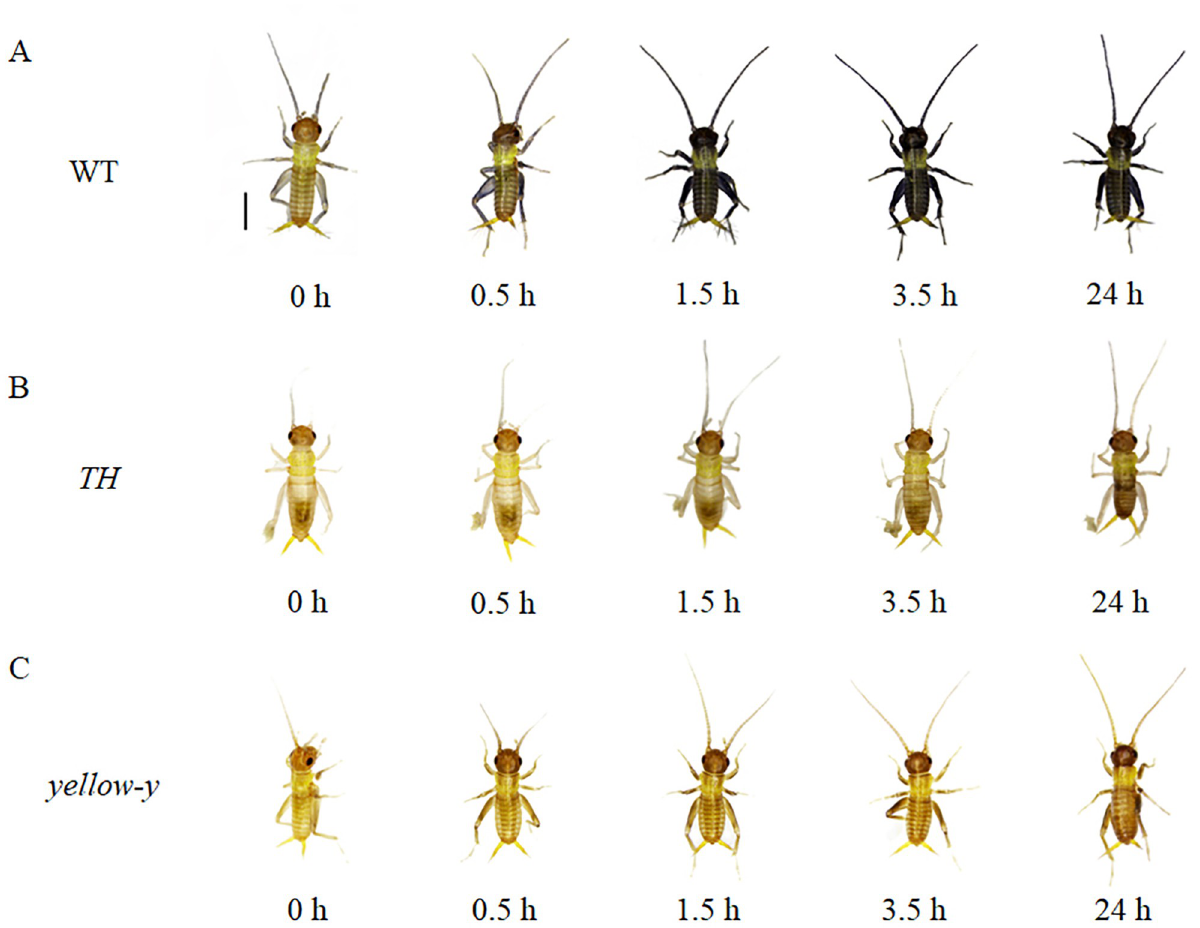
Fig 8. Pigmentation process in the epidermis of the G . bimaculatus . (A) WT pigmentation process. (B) Pigmentation process in TH knockout mutants. (C) Pigmentation process in yellow-y mutants. Bar = 1000 um.